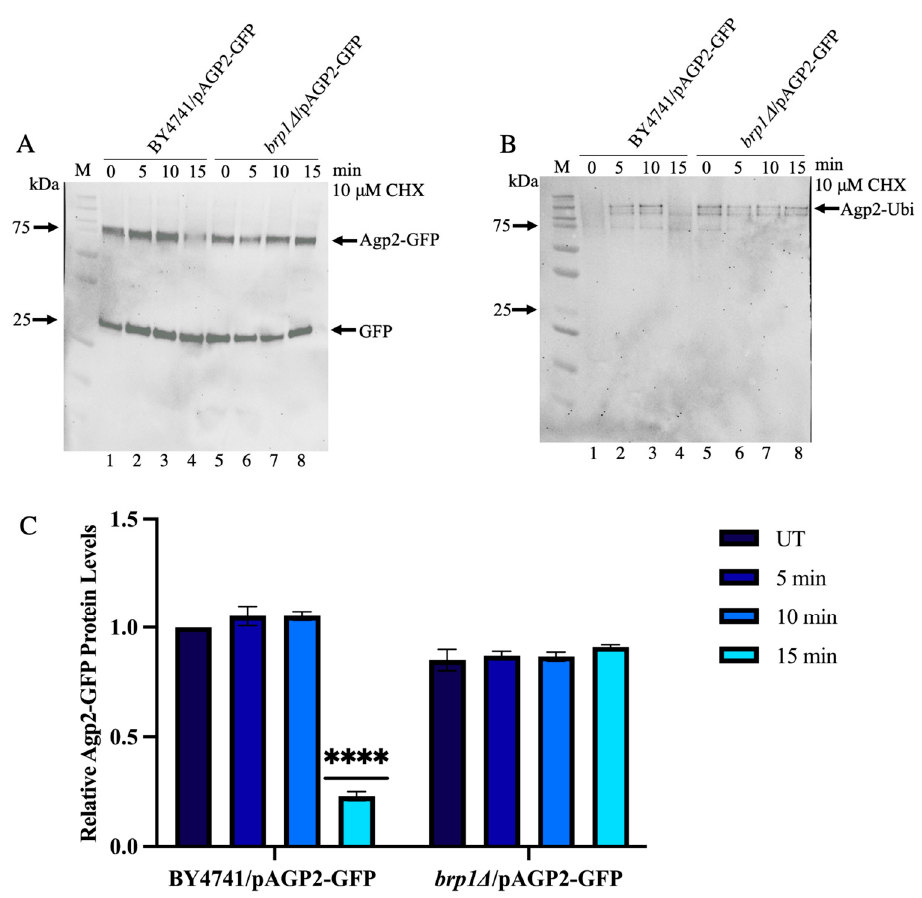
Figure 7. Analysis of immunoprecipitated Agp2-GFP from exponentially growing cultures of the WT and the brp1 ∆ mutant. ( A ) Immunoprecipitation of Agp2-GFP showing its disappearance in the WT and not in the brp1 ∆ mutant following CHX treatment. Briefly, total extracts were prepared from exponentially growing cells treated with CHX, subjected to pull-down assay using anti-GFP magnetic beads and probed by immunoblot with anti-GFP antibodies. ( B ) The same amount of the pull-down samples from panel ( A ) were analyzed by immunoblot probed with anti-ubiquitin antibodies. ( C ) Quantification of the relative level of the immunoprecipitated Agp2-GFP under the indicated conditions. M, prestained protein markers in kDa. Error bars indicate S.E. The data are representative of three biological replicates and analyzed by 2-way Anova Test. **** Is equivalent to p - value < 0.0001